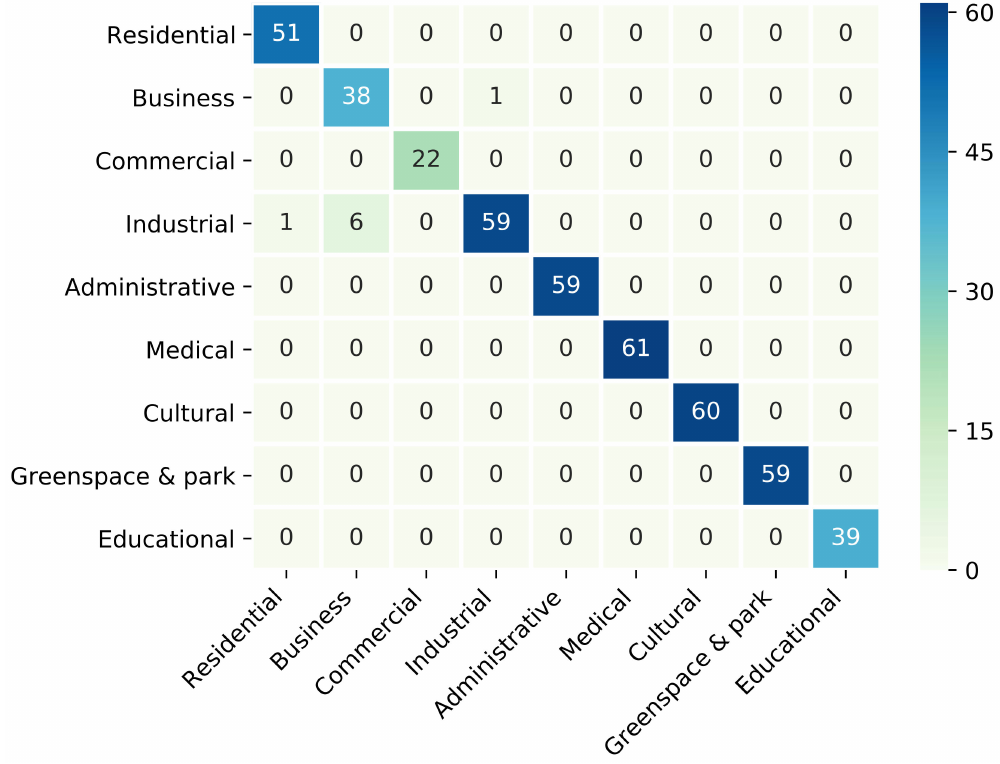
Figure 6. Confusion matrix for the accuracy assessment of AOI classification results.